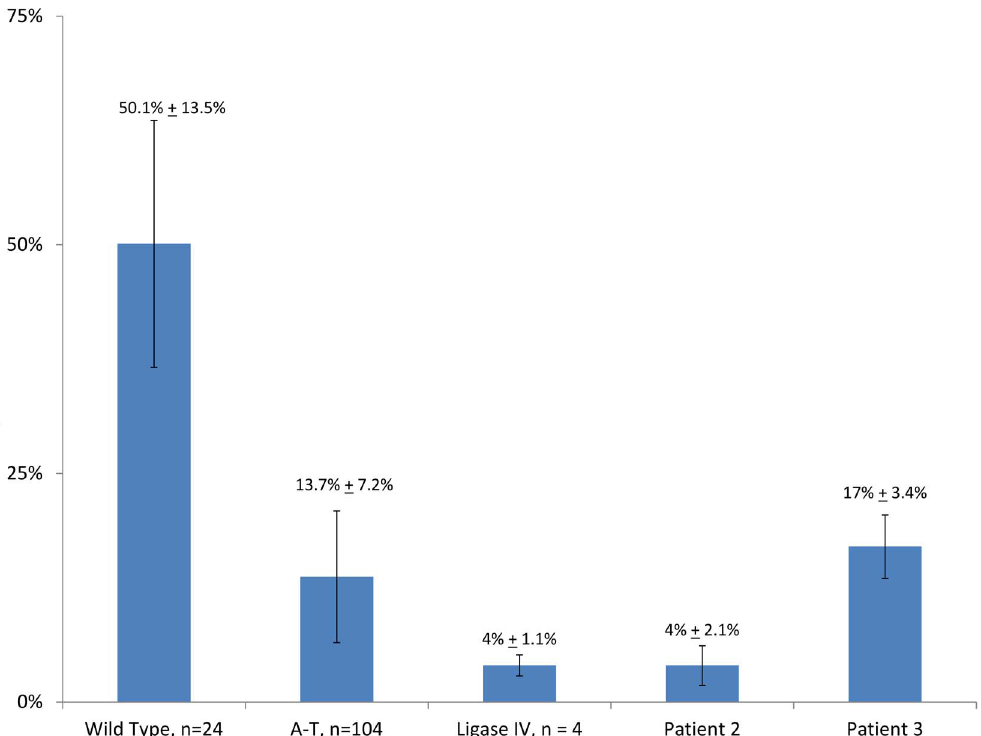
Figure 8. Colony survival assay demonstrates cellular radiosensitivity in Patients 2 and 3. Lymphoblastoid cell lines from Patients 2 and 3 were radiosensitive, as compared to controls. Experiments were performed in triplicate with the average of three experiments shown. WT = wild type; A-T = ataxia-telangiectasia control. Ligase IV = Ligase IV-deficient control.